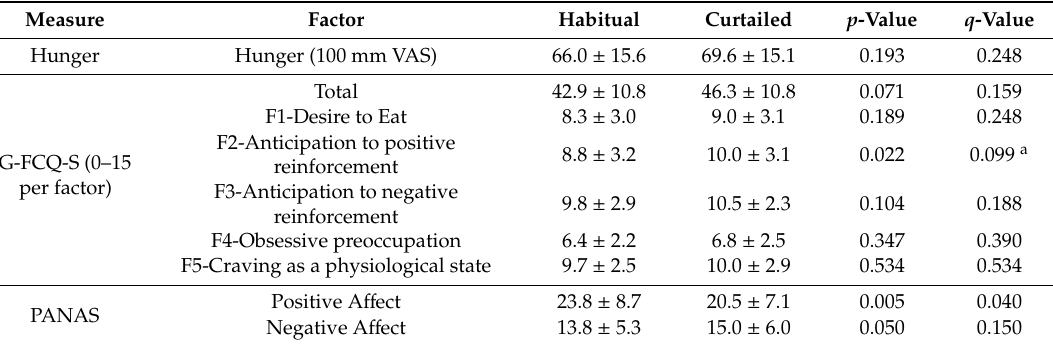
Table 3. Summary of state-dependent